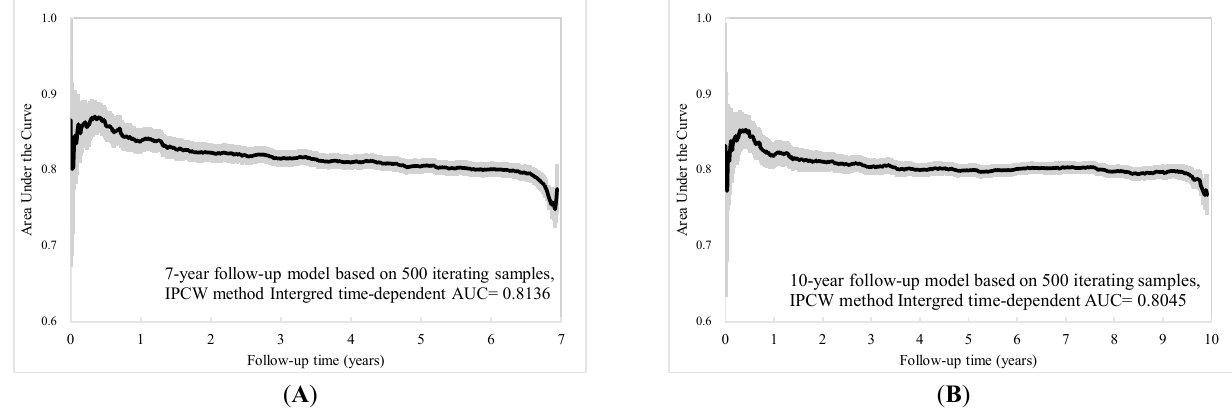
Figure 4. Time-dependent AUC with 95% confidence interval based on ( A ) 7-year and ( B ) 10-year follow-up.